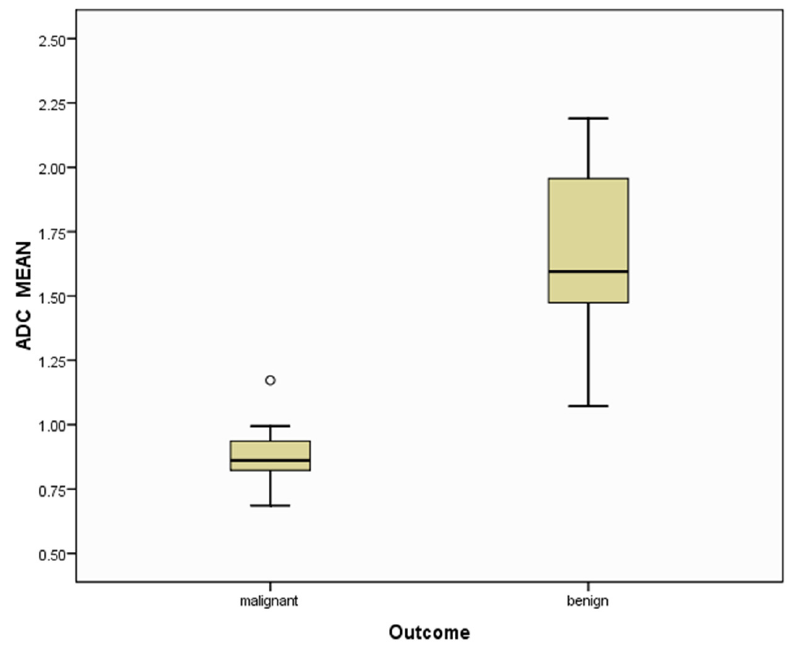
Figure 4. Box and whisker plot of the ADC mean value of the benign versus malignant mediastinal lymph nodes. ◦ -denotes the maximum ADC mean value in the malignant group.